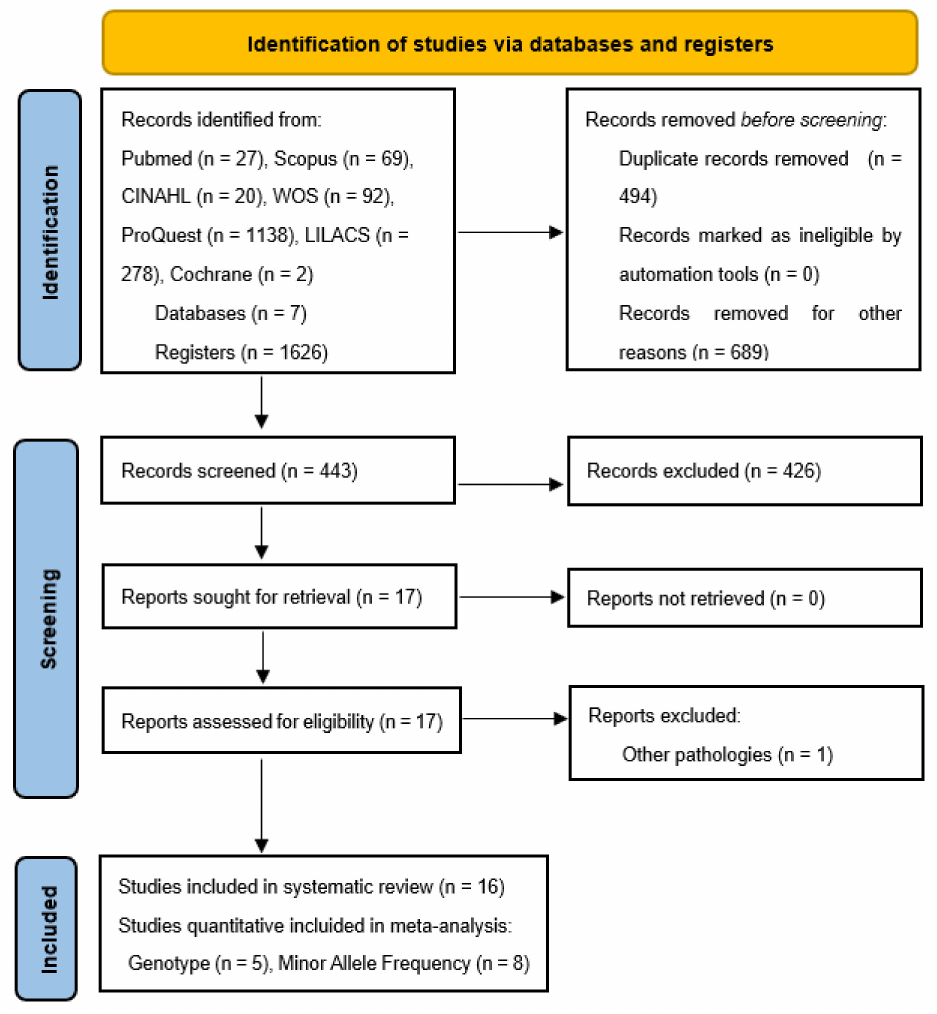
Figure 1. Flow chart of study selection for